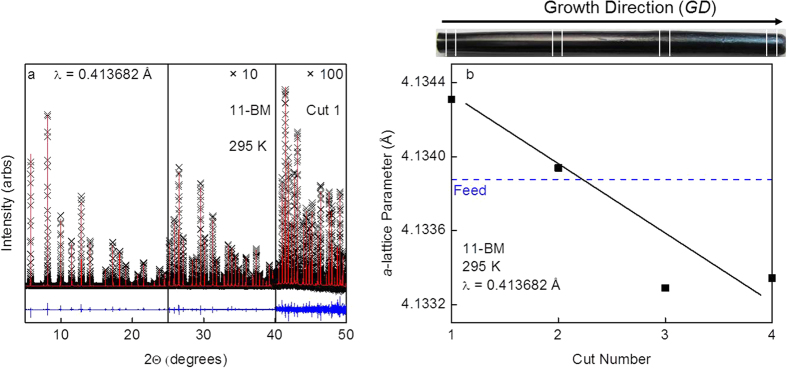
(a) Rietveld refinement to synchrotron X-ray diffraction data at T = 295 K collected on Cut 1 of the SmB6 floating zone grown single crystal. The black crosses, red lines, and blue lines correspond to the collected data, refined model, and difference curve respectively. The higher angle data are multiplied by ×10 (25 ≥ 2Θ ≥ 40) and × 100 (40 ≥ 2Θ ≥ 50) to highlight the quality of the fit. Fits to cuts 2–4 are of similar quality. (b) The refined a-lattice parameter values for cuts 1–4 versus cut number, where this value decreases with cut number. The line serves as a guide to the eye and the error bars are contained within the data points. Additionally, the refined a-lattice parameter value for the polycrystalline feed rod used for the growth of the FZ SmB6 crystal versus cut number (blue dashed line) is shown.